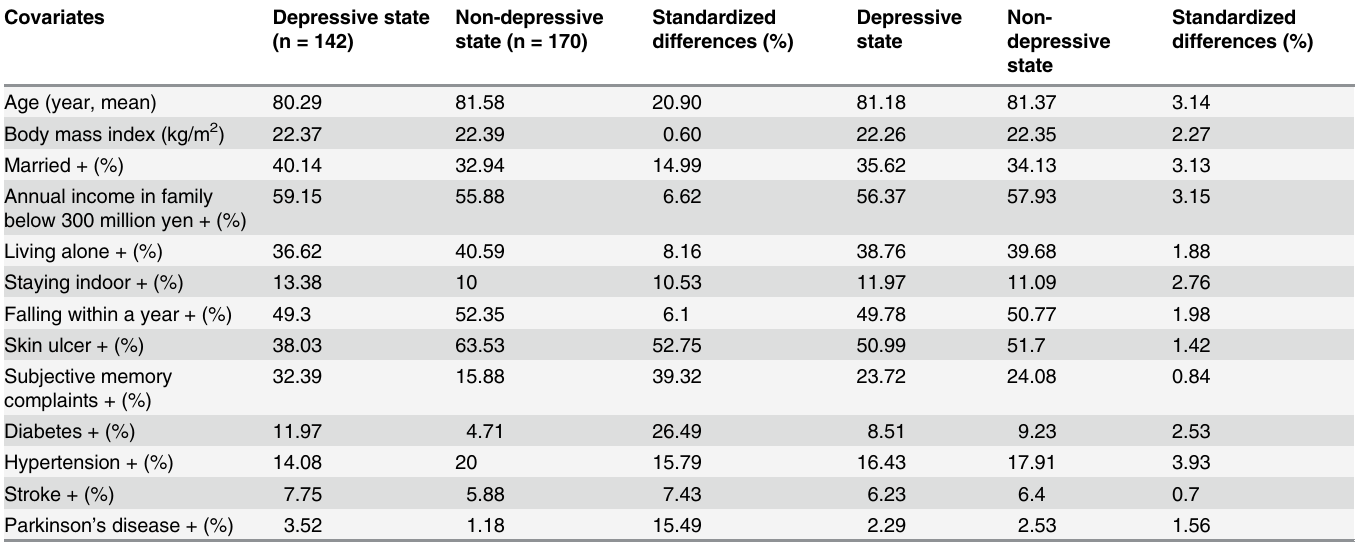
Table 3. Means, proportions, and absolute values of standardized differences before and after IPTW with propensity scores in women.